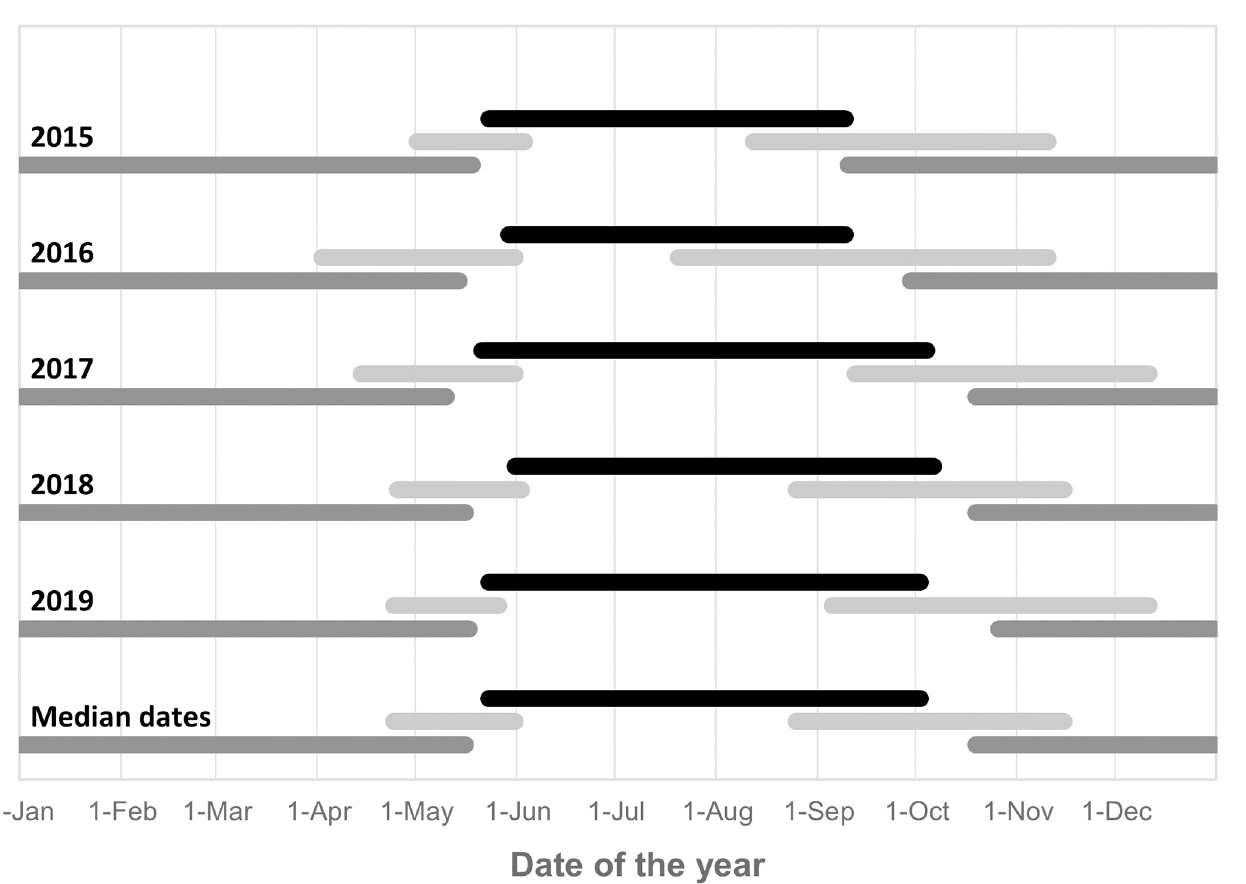
Fig 3. Annual phenology of 21 Vega gulls summering within the breeding range between 2015 and 2019. Lines represent the extend of breeding (black), migratory (light grey), and wintering (dark grey) periods (exact dates are given in S2 Table).